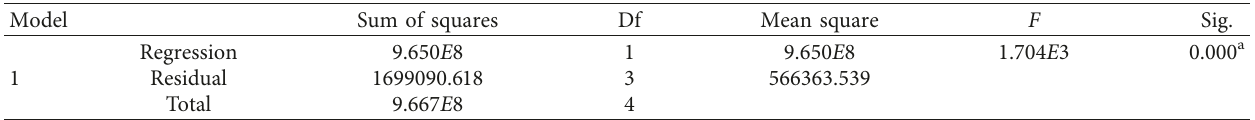
Table 3: Results of ANOVA analysis for calibration curve of MI.